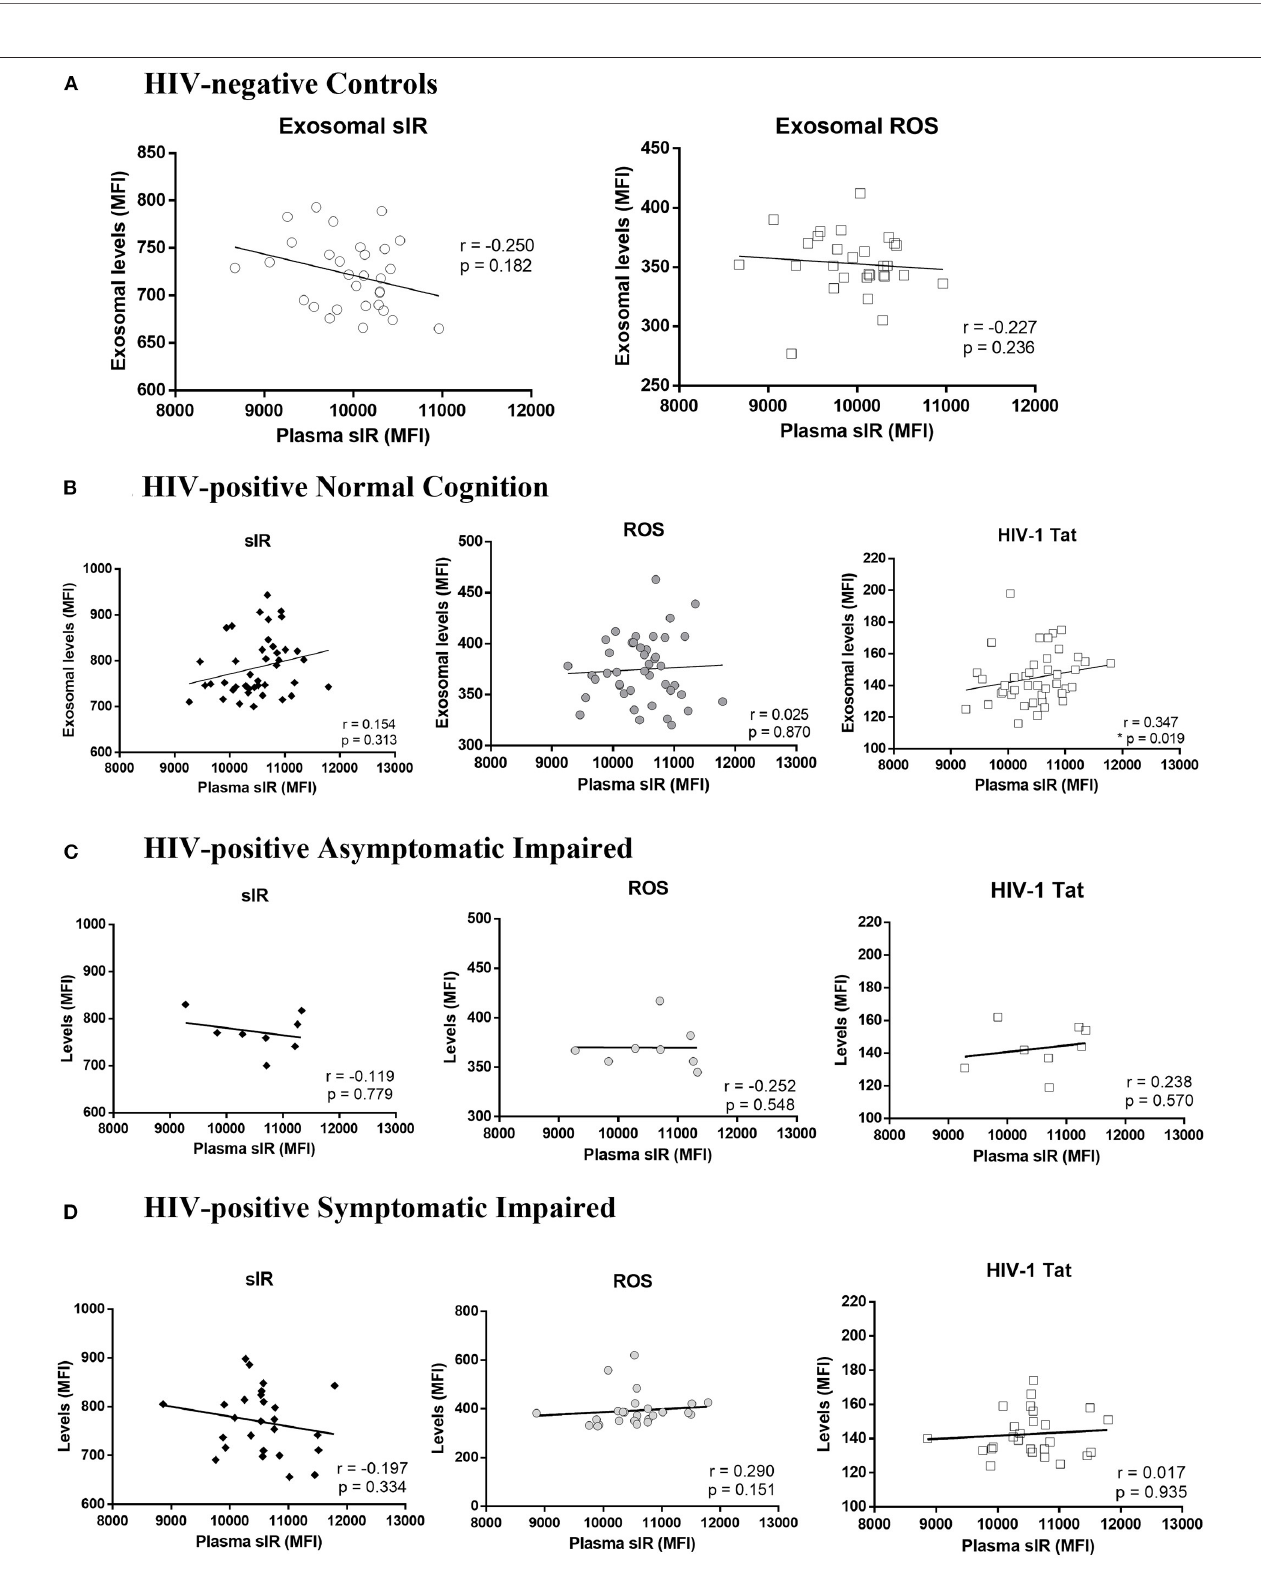
FIGURE 3 | Association between soluble insulin receptor levels in exosomes and plasma. Associations between plasma sIR and exosomal levels of sIR, ROS, and HIV-1 Tat (levels per exosome) were determined by Spearman’s correlations tests in HIV-negative controls (A) and HIV-infected women with normal cognition (B) , asymptomatic impairment (C) , and symptomatic impairment (D)